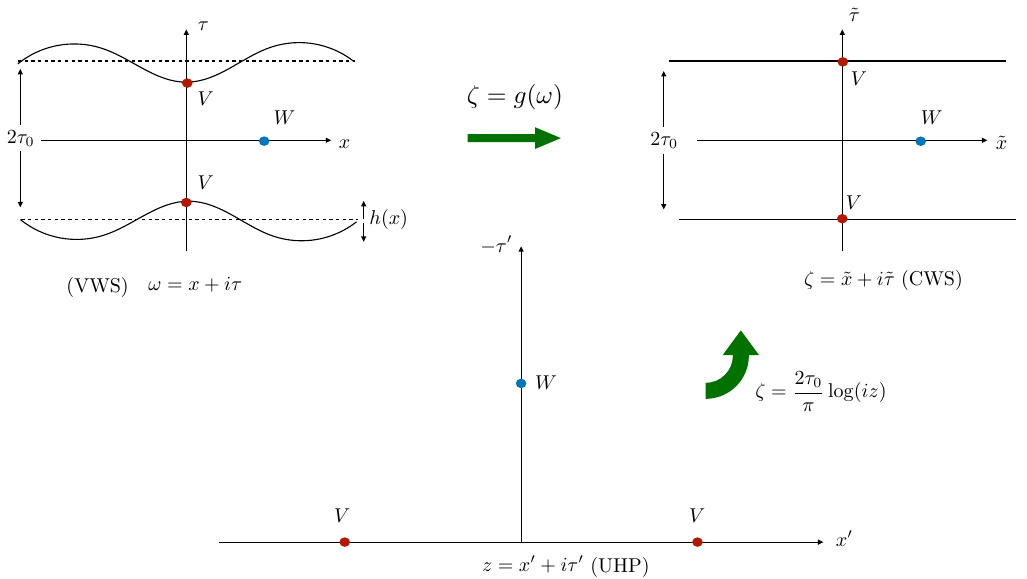
Figure 1 . The conformal maps from VWS to CWS to UHP. The explicit operator configuration, corresponding to the b -OTOC, is given in the UHP where two operators lie on the boundary and one operator is located inside the